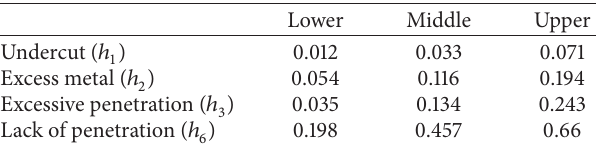
Table 6: Centres for imperfection clusters (mm).